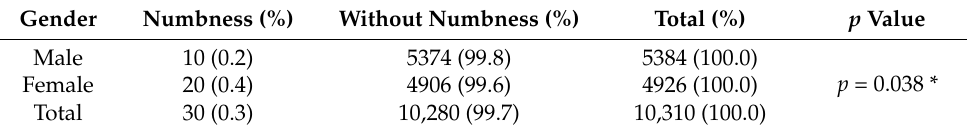
Table 11. Association between gender and numbness.